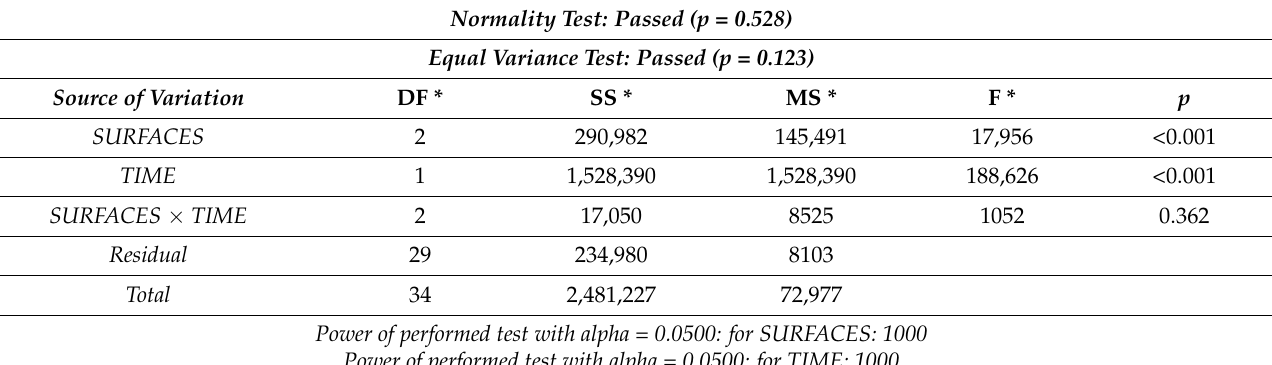
Table 2. Summary of the statistical results for two-way ANOVA. Normality Test: Passed (p = 0.528) Equal Variance Test: Passed (p = 0.123)